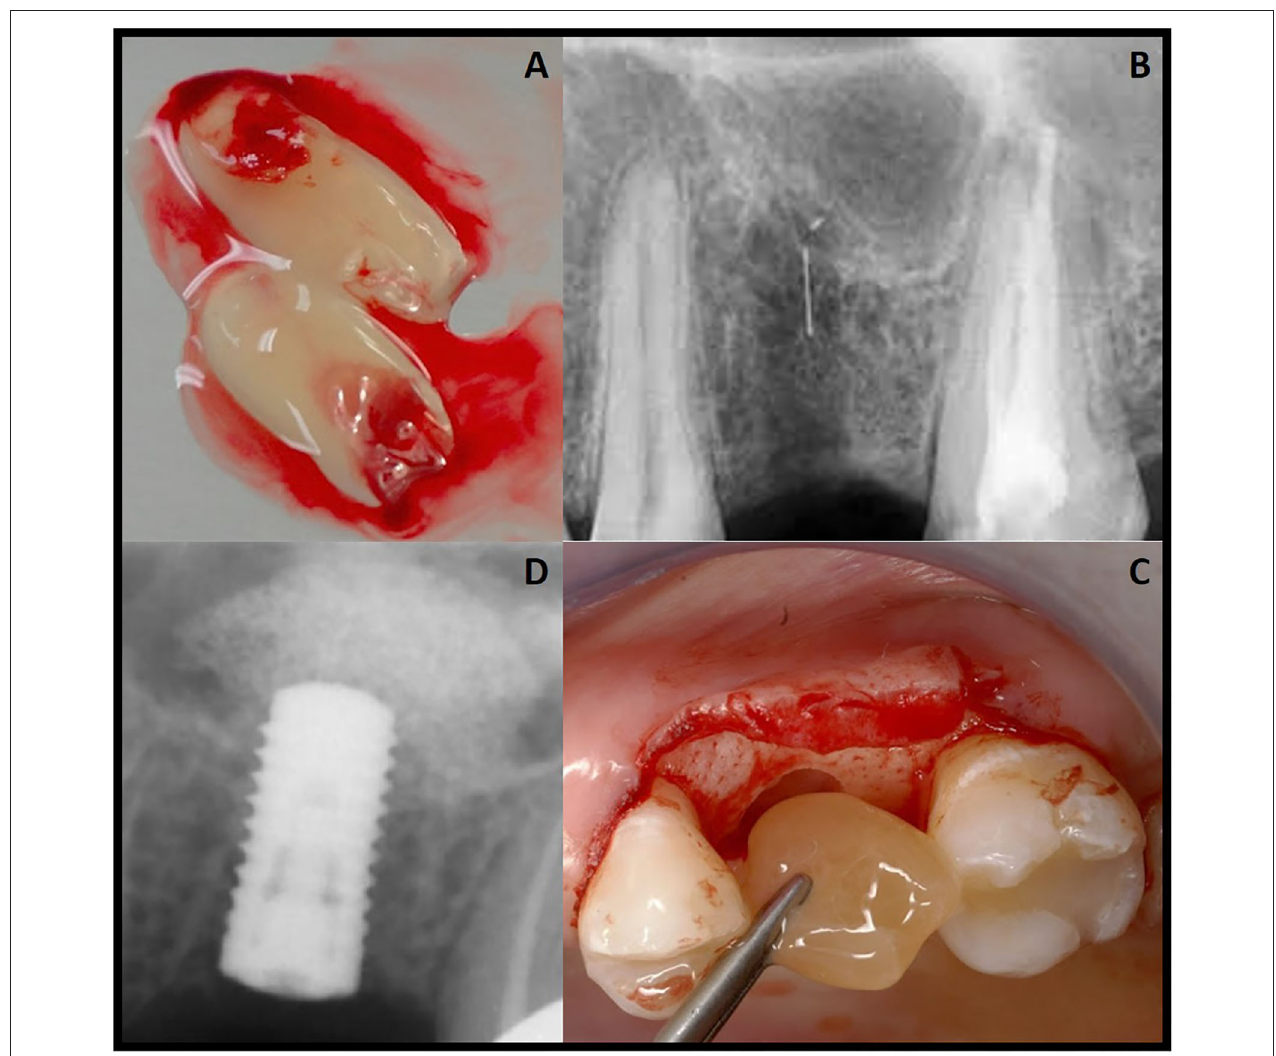
FIGURE 2 | Clinical case presentation of (A) prepared L-PRF use/ application in (B) a maxillary sinus floor lift and augmentation procedure prior (C) to immediate dental implant placement (D) .